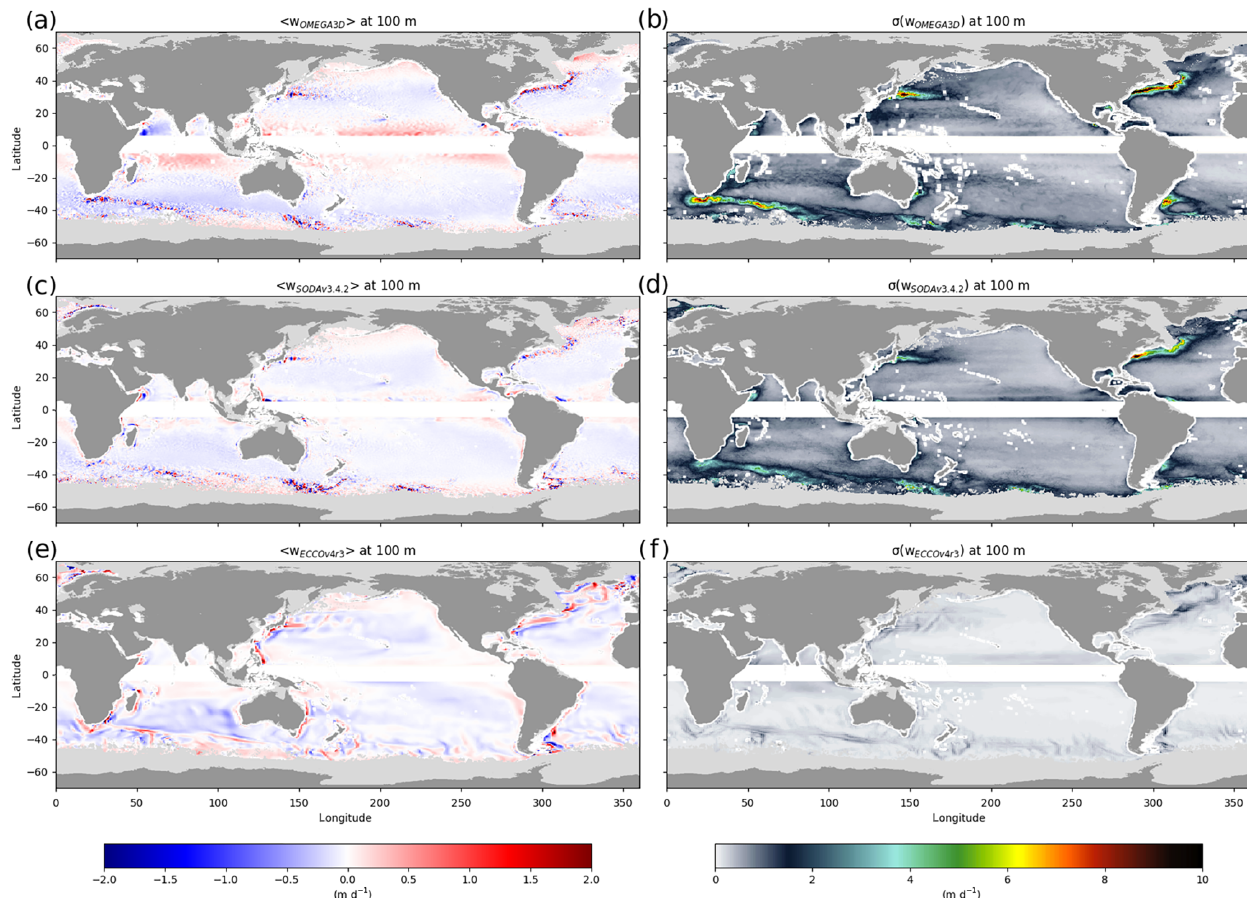
Figure 1. Mean vertical velocity at 100m (a, c, e) and related standard deviation (b, d, f) computed from OMEGA3D (a, b) , SO- DAv3.4.2 (c, d) and ECCOv4r3 (e, f) data on the OMEGA3D domain over their 23-year overlapping period. Areas shallower than 100m or contaminated at least once by sea ice within the averaging period are masked in light